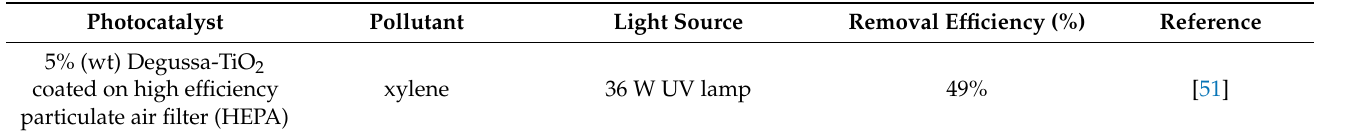
Table 3. Photocatalytic activity of PNT/NWPF of current work and other reported literature data for xylene pollutant